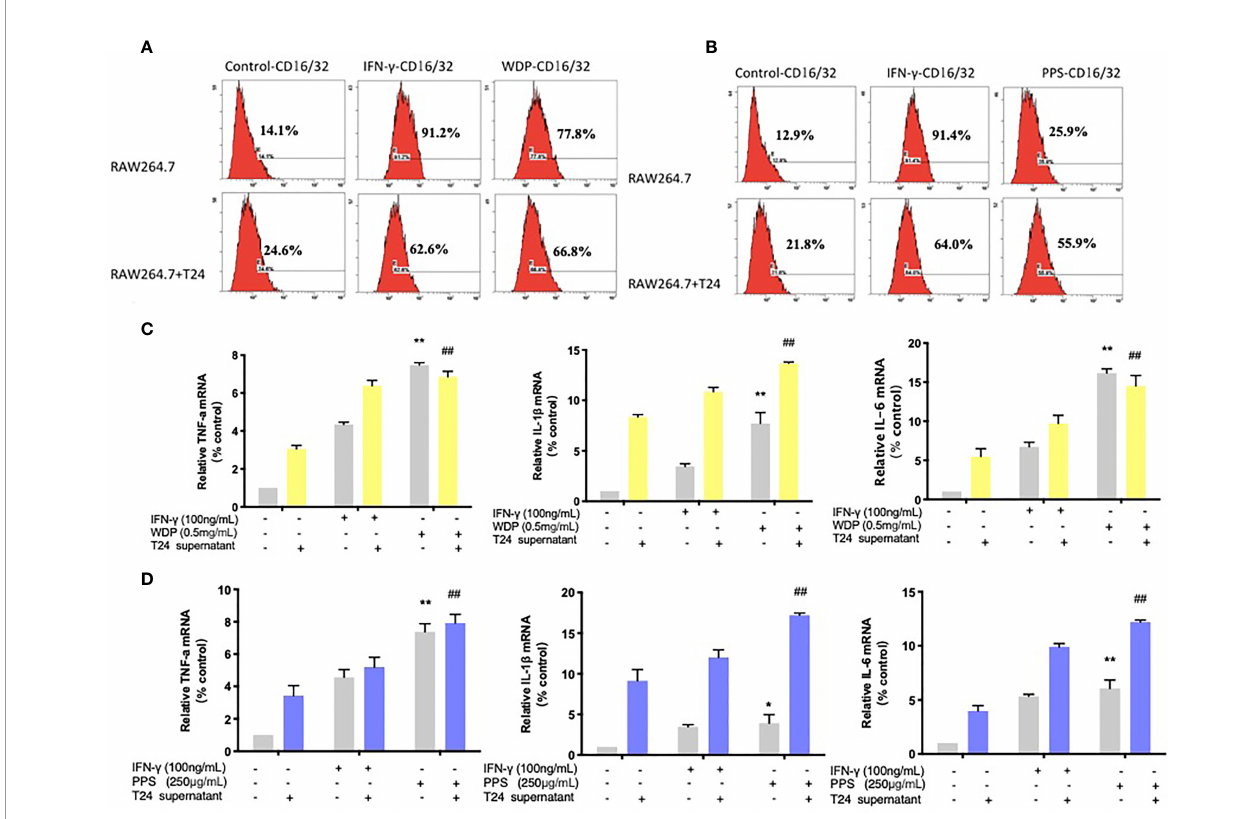
FIGURE 3 | Polyporus water extract and polysaccharides promoted TAMs toward the M1 subtype. (A, B) Flow cytometry detection of CD16/32, the signature marker of M1 cells. (C) The expression of IL-1 b , TNF- a , and IL-6 mRNA in RAW 264.7 cells treated with polyporus WDP for 24 h, followed by measuring the mRNA levels by qRT – PCR. (D) The expression of IL-1 b , TNF- a , and IL-6 mRNA in RAW 264.7 cells treated with PPS for 24 h, followed by measuring the mRNA levels by qRT-PCR. Values are given as the mean ± SD from three independent experiments. Compared with the RAW 264.7 control group, ## P < 0.01; compared with the RAW 264.7+T24 control group, * P < 0.05 and ** P <